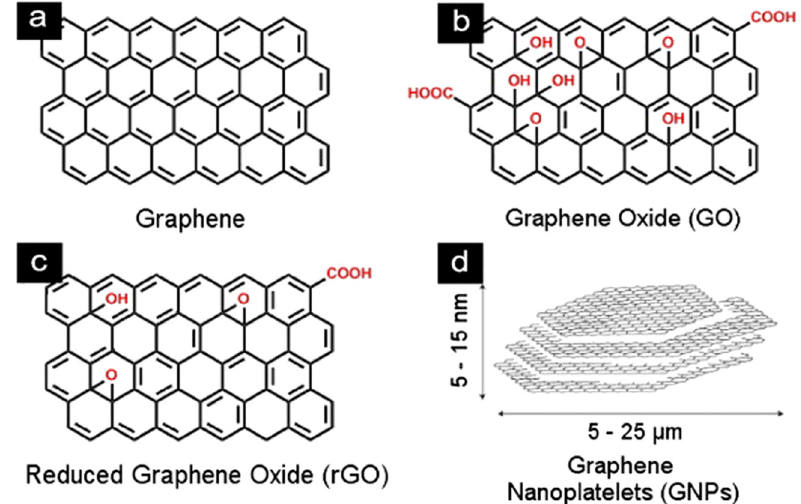
Figure 10: Schematic diagram of ( a ) graphene, ( b ) graphene oxide, ( c ) reduced grapheme oxide, and ( d ) graphene nanoplatelets. Reproduced from ref. [ 88 ]